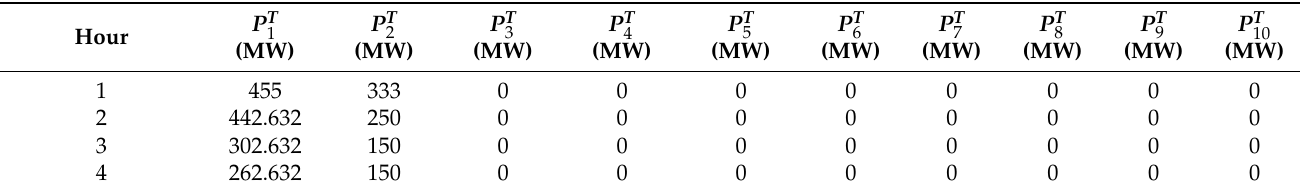
Table A4. Optimal operation scheduling for the conventional thermal units in case 4.